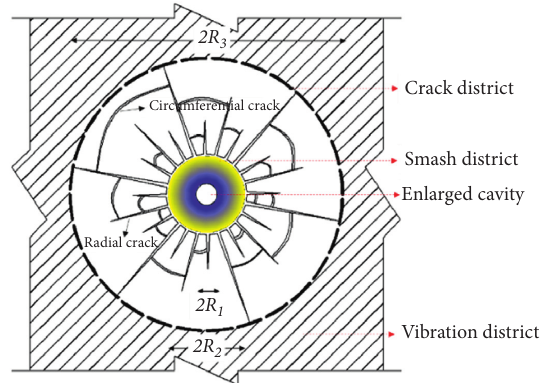
Figure 1: Division of rock blasting